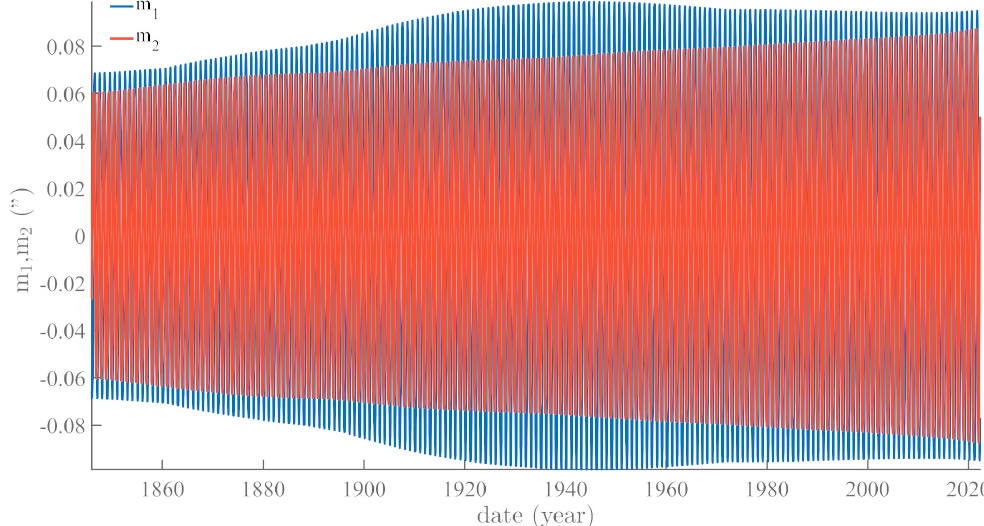
Figure 1. The iSSA annual component of rotation pole coordinates m 1 and m 2 from 1850 to the present. The annual and semi-annual iSSA components of lod are modulated (Figure 2a,b). The annual component grows slightly until 1990, flattens until 2013, and then starts growing again. The semi-annual component decreases regularly over the sixty years of avail- able data.